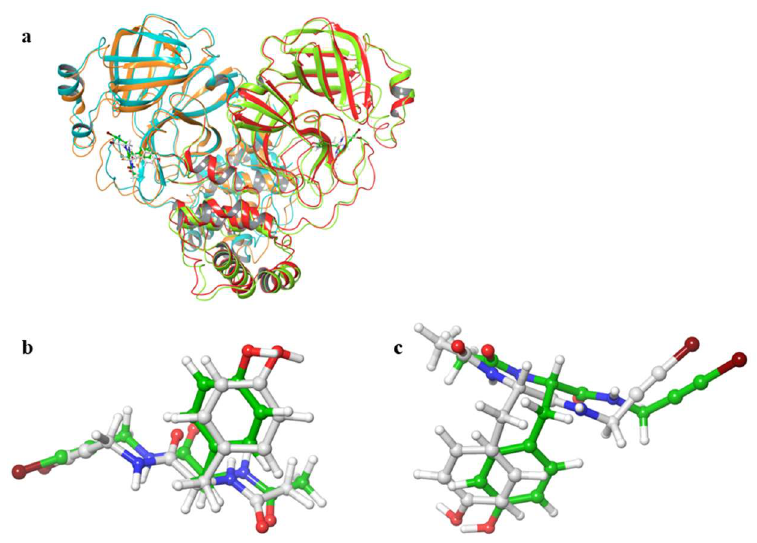
Figure 2. 3D structures of SARS-CoV-2 Mpro before and after MD simulations. ( a ) Protein-ligand complex. Red and orange ribbons indicate chains A and B before MD simulations (0 ns), and light green and light blue indicate chains A and B after MD simulations (1000 ns). ( b ) Ligand in chain A. ( c ) Ligand in chain B. White and green ligands are the structures before and after MD simulation, respectively.